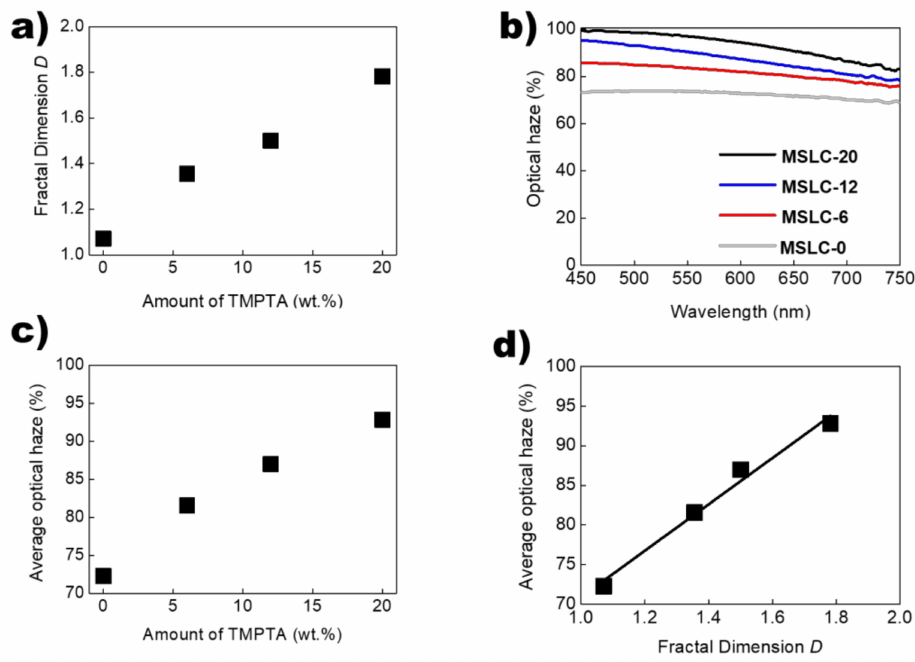
Figure 3. ( a ) D of the LC droplet surrounded by polymer networks as a function of the fraction of the multi-functional acrylate within the host polymer matrix. ( b ) Optical haze profiles of the four MSLC films prepared. ( c ) Average optical haze over the wavelength range of 450 ≤ λ ≤ 800 nm as a function of the blended amount of multi-functional acrylate TMPTA within the host polymer matrix. ( d ) Plot of average optical haze versus the D of the LC droplets in the four MSLC